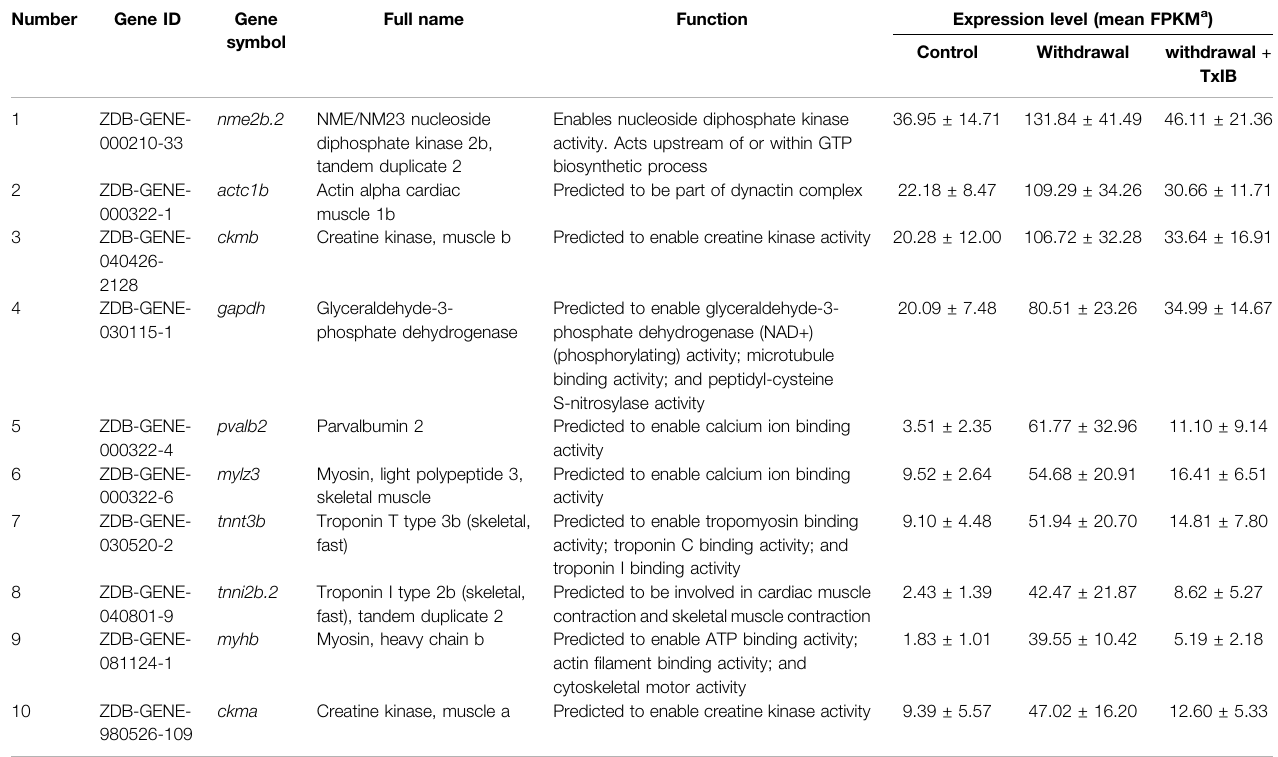
TABLE 2 | Top 10 genes that were signi fi cantly regulated by TxIB